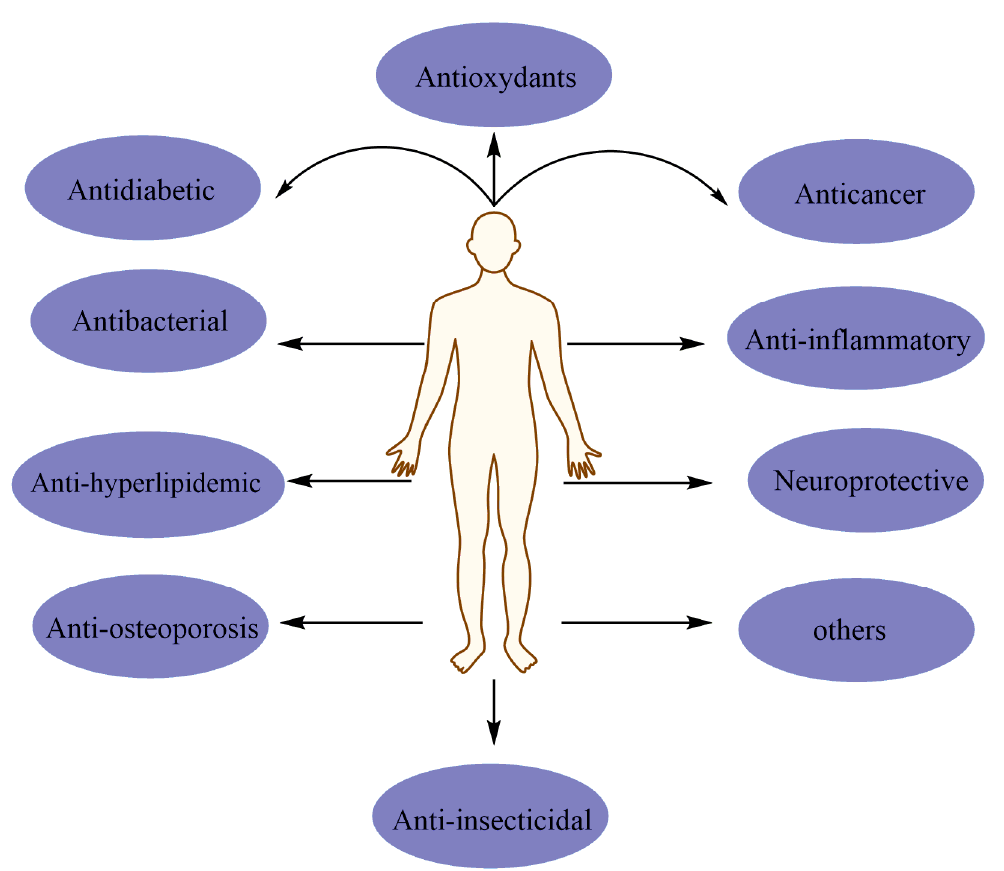
Figure 2. Main biological activities of chrysoeriol on human pathologies.